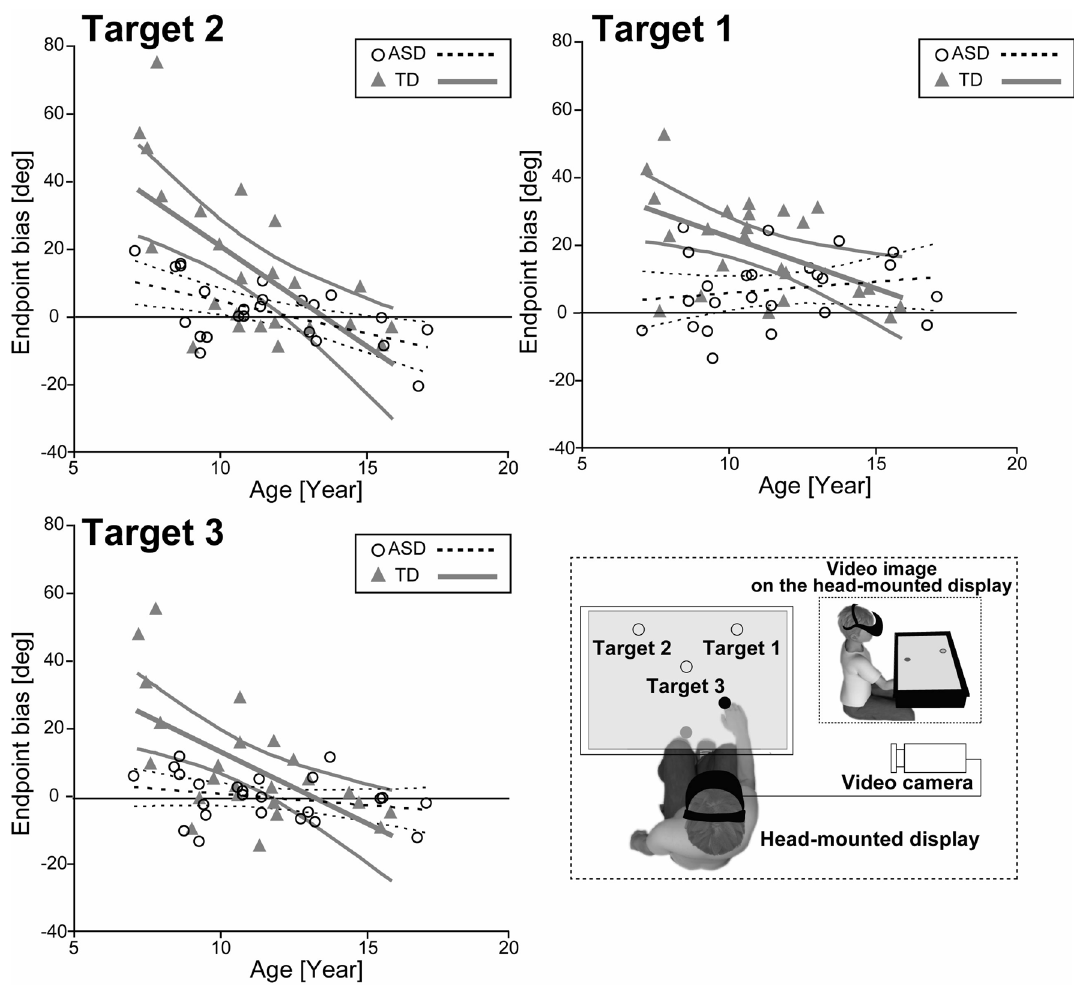
Figure 3. Developmental trajectories for endpoint biases during the perspective-transformed task for each target in both groups. Open circles indicate children with autism spectrum disorders (ASD) and filled triangles indicate typically developing children (TD). Dashed lines indicate the trajectories with a 95% confidence interval for the ASD group. The thick line indicates the trajectories with a 95% confidence interval for the TD group.